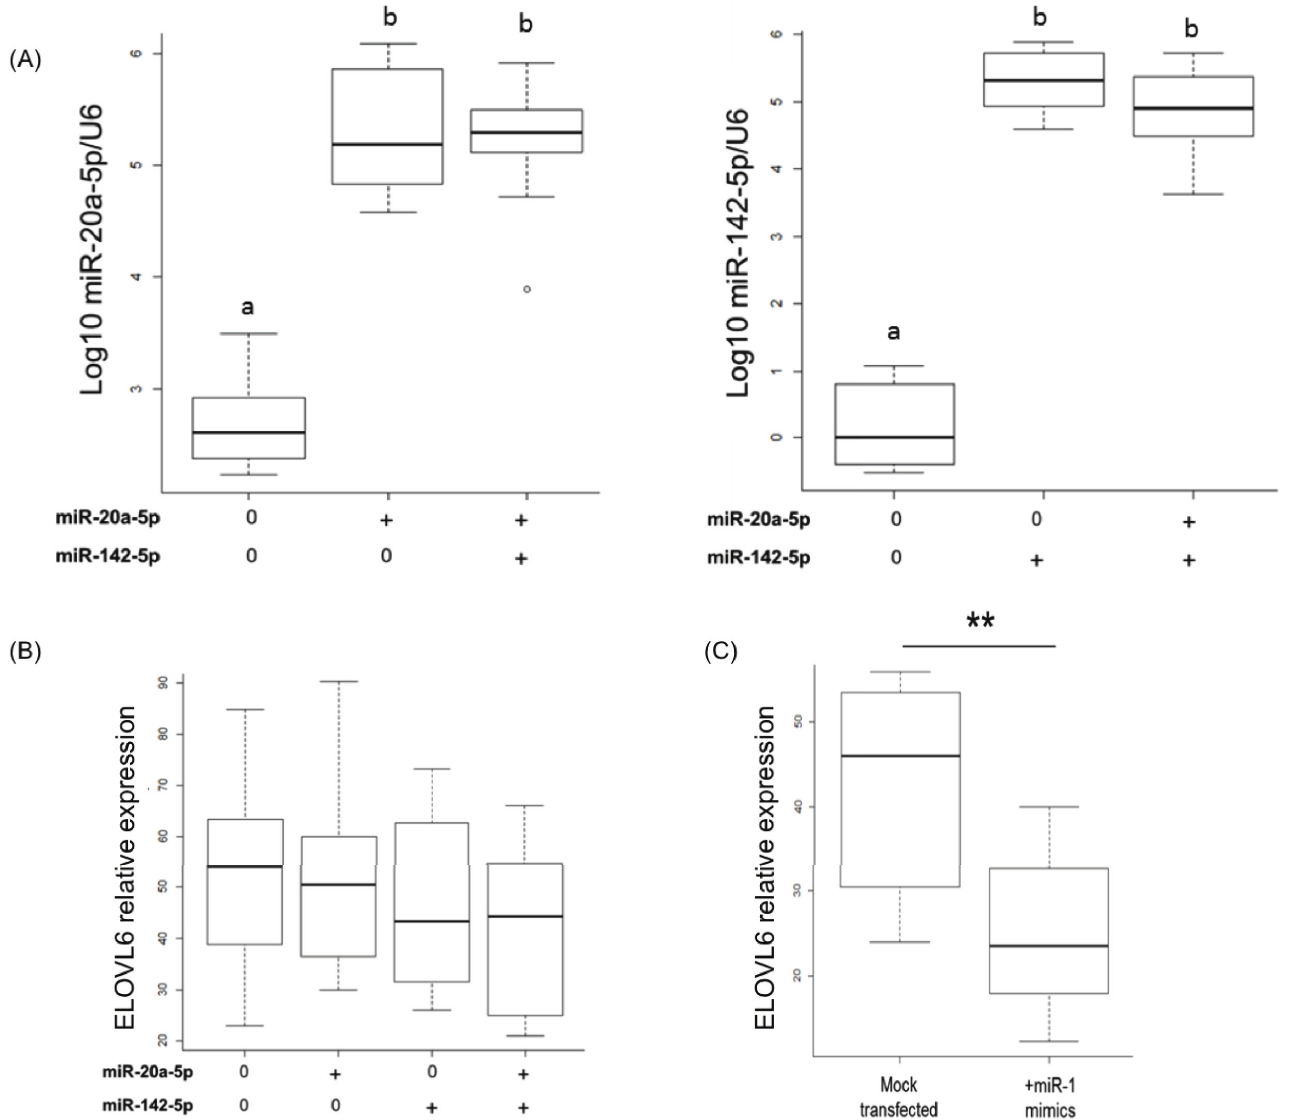
Fig 5. Effect of miR-20a-5p and miR-142-5p over-expression on ELOVL6 expression in BME-UV1 cells. (A) Levels of miR-20a-5p and miR- 142-5pafter transfectionwith miRNA mimics. Data were obtained by RT-qPCR, normalized regardingU6 values and representedas log10. ELOVL6 expressionafter transfectionof miR-20a-5p and miR-142-5p (B) or miR-1-3p(C). Data were obtainedby RT-qPCR, and normalizedregardingto GAPDH values. Data are the mean of four transfectionexperiments. a, b:p < 0.01; ** :0.01 < p < 0.05, n = 12.